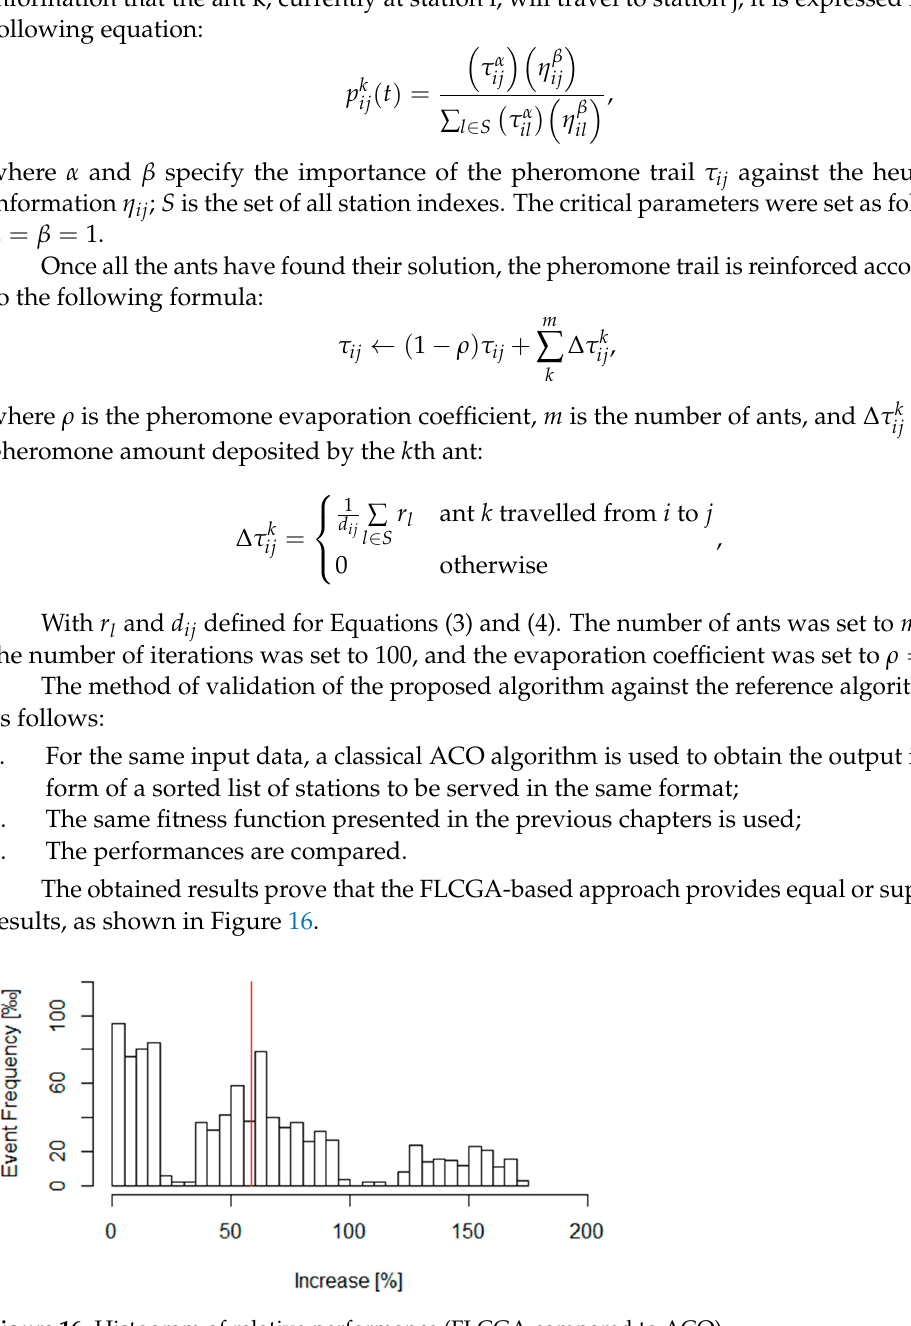
Figure 16. Histogram of relative performance (FLCGA compared to ACO).